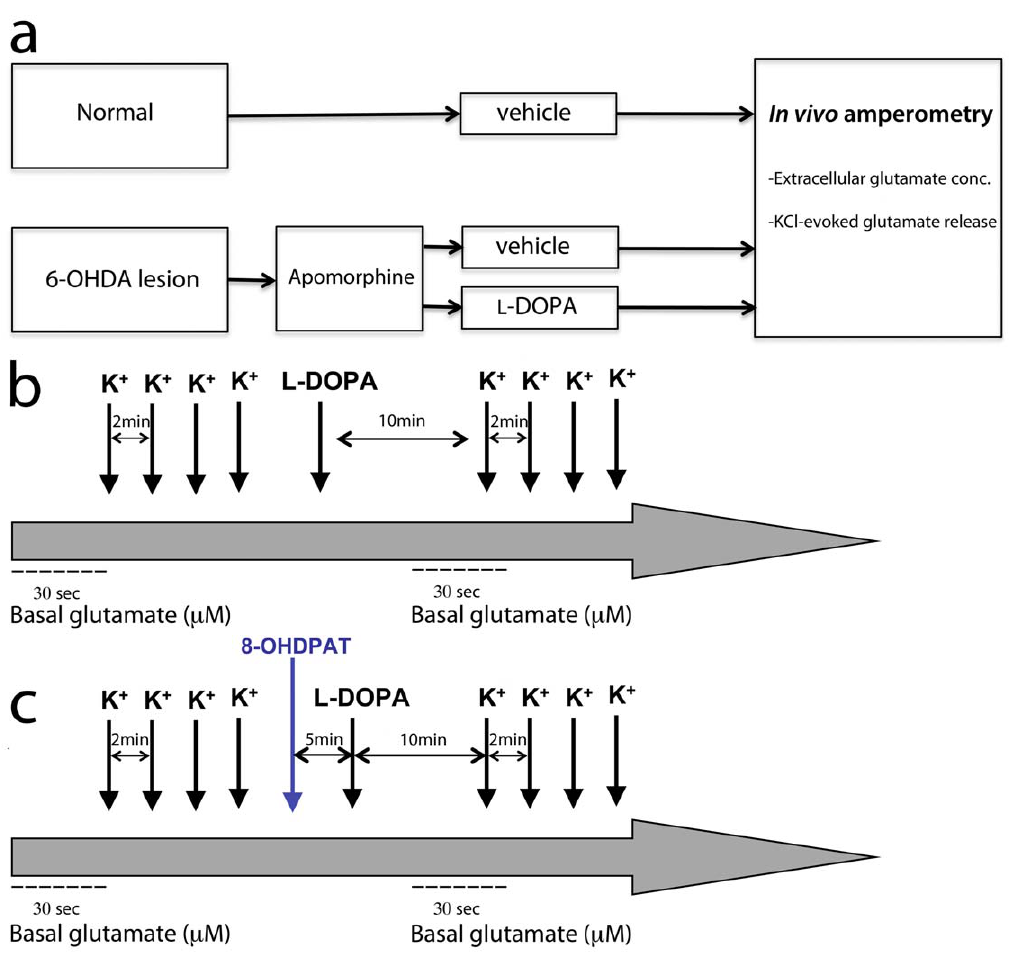
Figure 1. Illustration of the study design (a) and experimental setup during invivo recordings of basal glutamate concentration and glutamate release stimulated by KCl-ejections (K + ) before and after striatal L -DOPA application (b) and the administration of 8- OHDPAT (c).